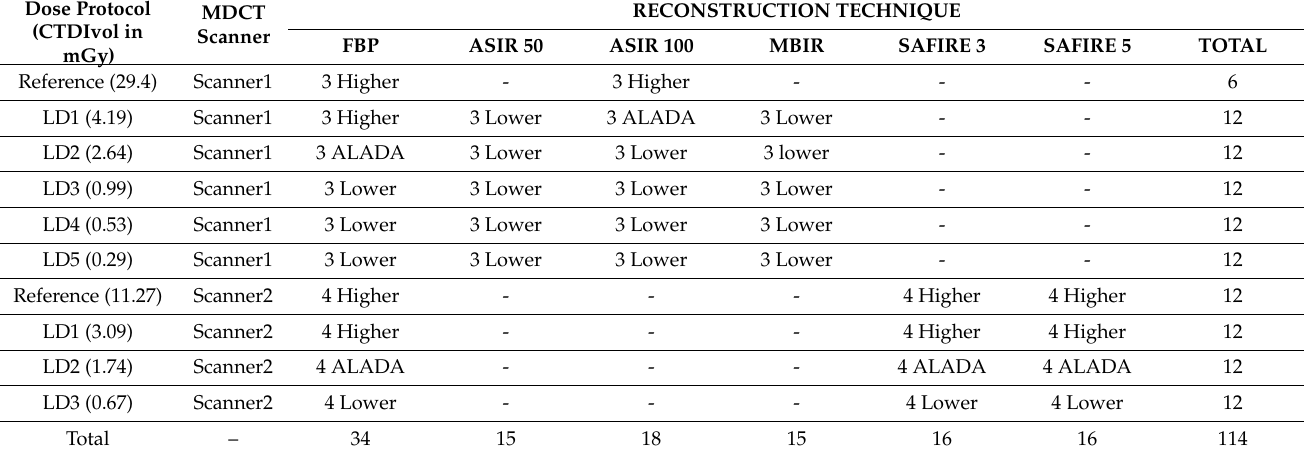
Table 2. Number of imaged cadavers and their ALADA designation (ALADA dose, or higher or lower than the ALADA dose) according to the MDCT scanner, reconstruction technique, and dose. CTDIvol: volume CT dose index; LD: low dose protocol; mGy: milli Grays; FBP: filtered backprojection; ASIR: adaptive statistical iterative reconstruction; MBIR: model based iterative reconstruction; SAFIR: sinogram-affirmed iterative